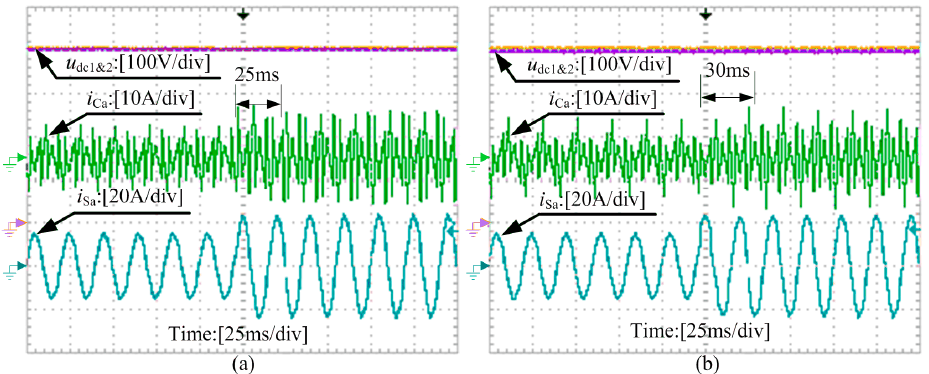
Figure 17. Dynamic response of NPC-SAPF by using PR and VPI control methods. ( a ) PR control method; and ( b ) VPI control method.